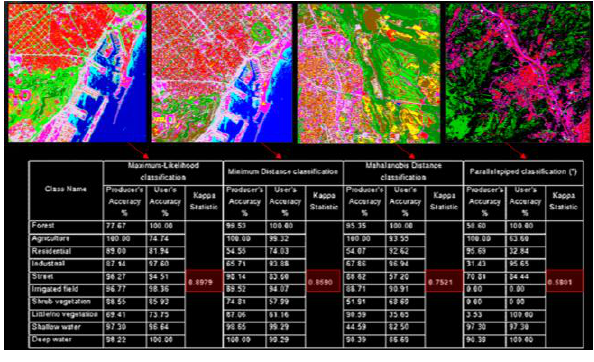
Figure 1.Per pixel classification